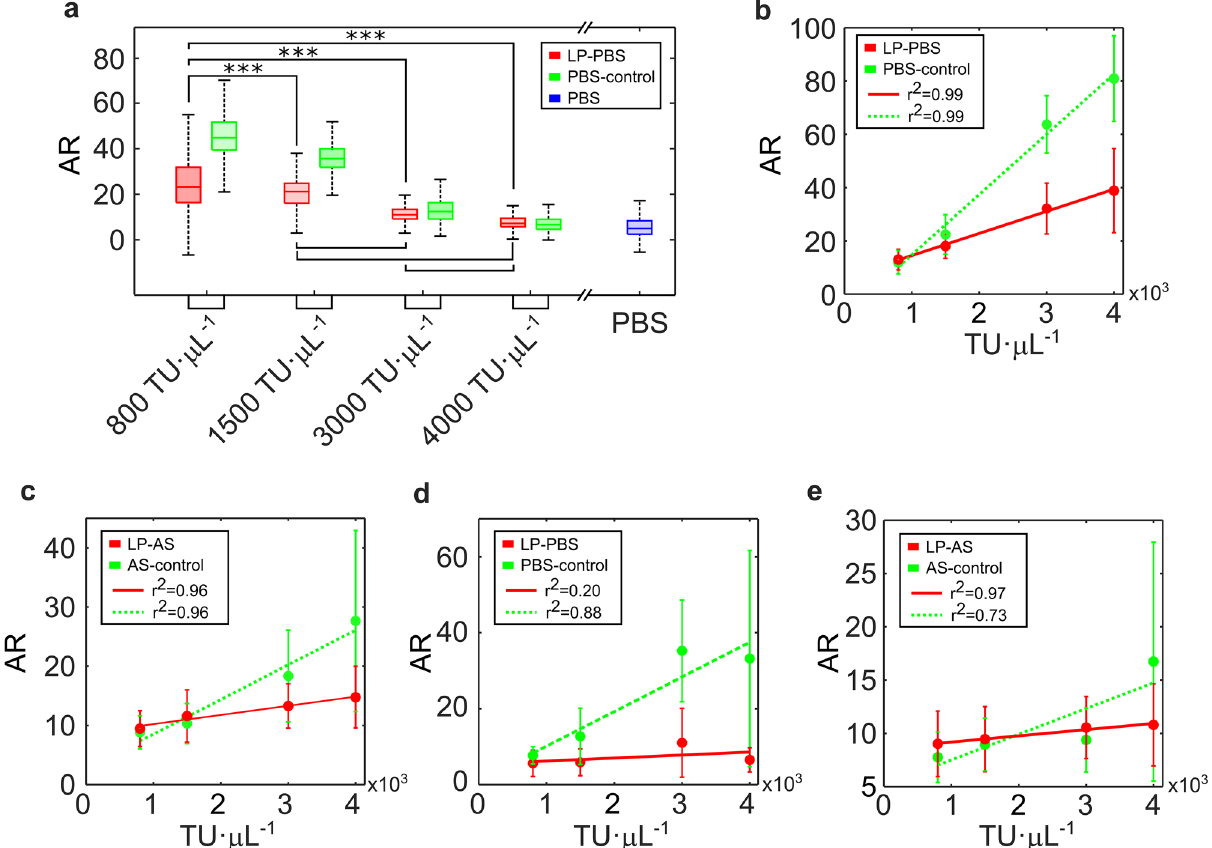
Figure 5. Viral load quantification. ( a) median value of the shape feature named area ratio (AR see supplementary material), against viral load of the preparation. The boxes represent the interquartile range, and the whiskers show 2.7 times the standard deviation. Lentiviral particles in PBS (LP-PBS) and their corresponding negative controls (PBS-control). Additionally, the estimator was obtained for PBS alone. *** p-value < 0.0001 using Wilcoxon rank-sum test. ( b) mean value of the AR obtained from LP-PBS and PBS- control. ( c) mean value of the AR obtained from LP-AS and AS-control. ( d) mean value of the AR obtained from LP-PBS and PBS-control upon complete evaporation of the water content. ( e) mean value of the AR obtained from LP-AS and AS-control upon complete evaporation of the water content. ( b–e) the error bars denote the standard deviation. The green dashed line and the red solid line represent the linear correlation, and r denotes the linear correlation